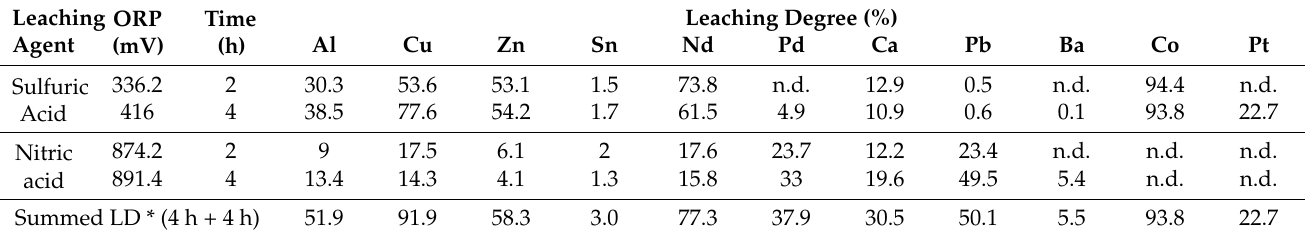
Table 4. Two-pronged leaching parameters and element leaching degree without